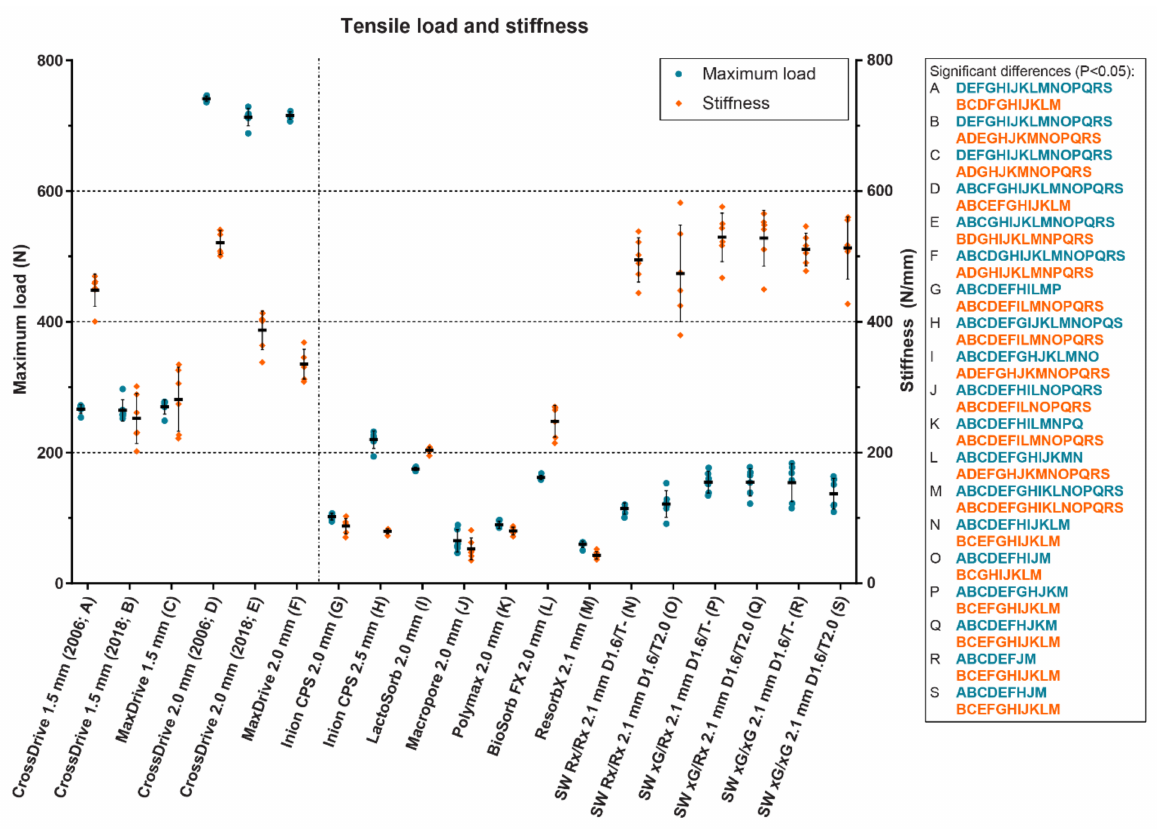
Figure 7. The tensile load and stiffness of 13 biodegradable and 6 titanium osteosynthesis systems commonly used in oral and maxillofacial surgery. The characters in blue and orange represent signifi- cant pairwise differences in maximum load and stiffness, respectively, between the corresponding systems using a one-way analysis of variance adjusted for multiple testing. The titanium CrossDrive (2006) plates consisted of 100% titanium produced by stamping of plates. The titanium CrossDrive (2018) and MaxDrive consisted of 100% titanium produced by milling of plates. The titanium Cross- Drive (2006 and 2018) and MaxDrive screws consisted of a Ti6Al4V alloy. The composition of each biodegradable system is described in Table 1. Error bars: mean values ± standard deviation. Ti6Al4V, 90% titanium, 6% aluminum and 4% vanadium alloy; SW, SonicWeld; D, drill diameter (mm); T, tap diameter (mm). The dotted line separates the titanium (left) and biodegradable systems (right). Reprinted with permission from